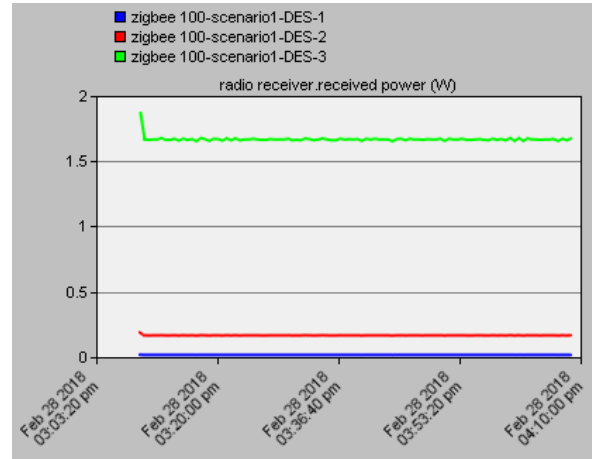
Figure 3. Fluctuations in Received Power for the first Value Group. (X axis: Time, Y axis: Received power).